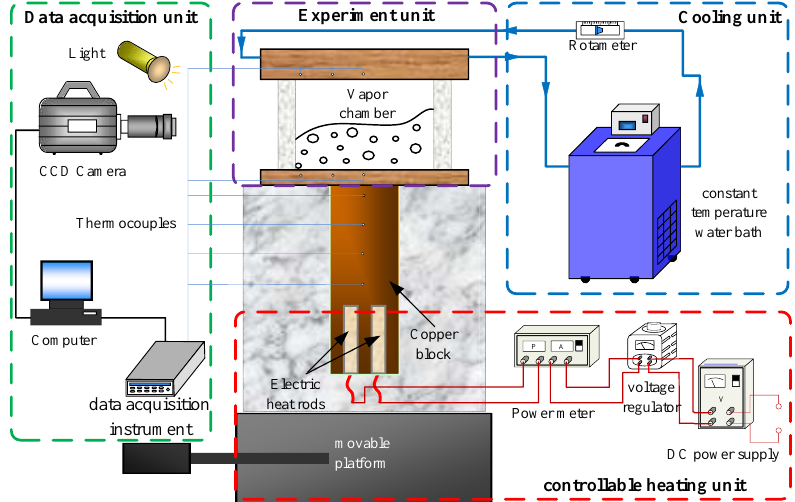
Figure 1. Schematic of experimental setup.